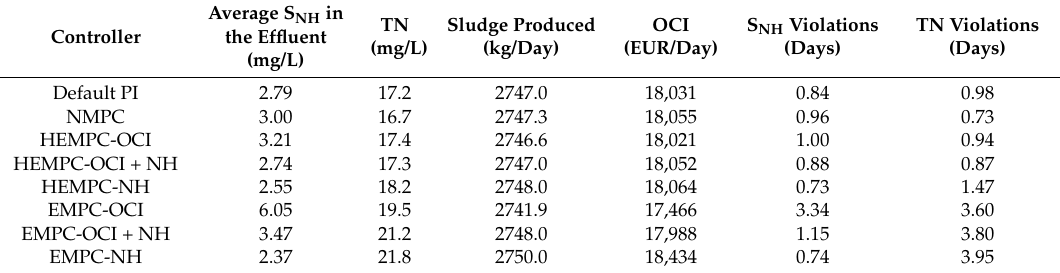
Table 3. Performance indices of the mean operating variables of the plant that are different from the variables included in the optimization problem (computed for a four-day operation period under dry weather